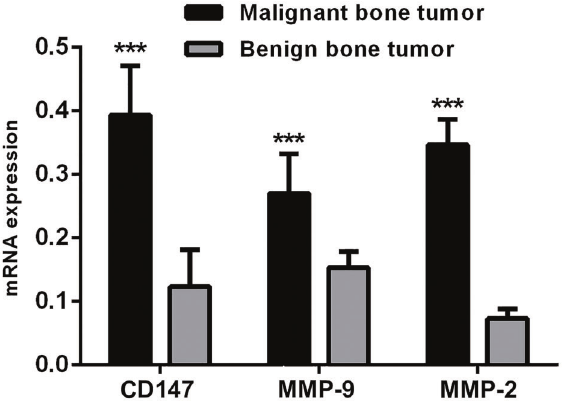
Figure 1. CD147, matrix metalloproteinases (MMP)-9, and MMP-2 mRNA relative expression vs GAPDH in malignant and benign bone tumor. Data are reported as means ± SD. ***P o 0.001, compared with the benign bone tumor ( t